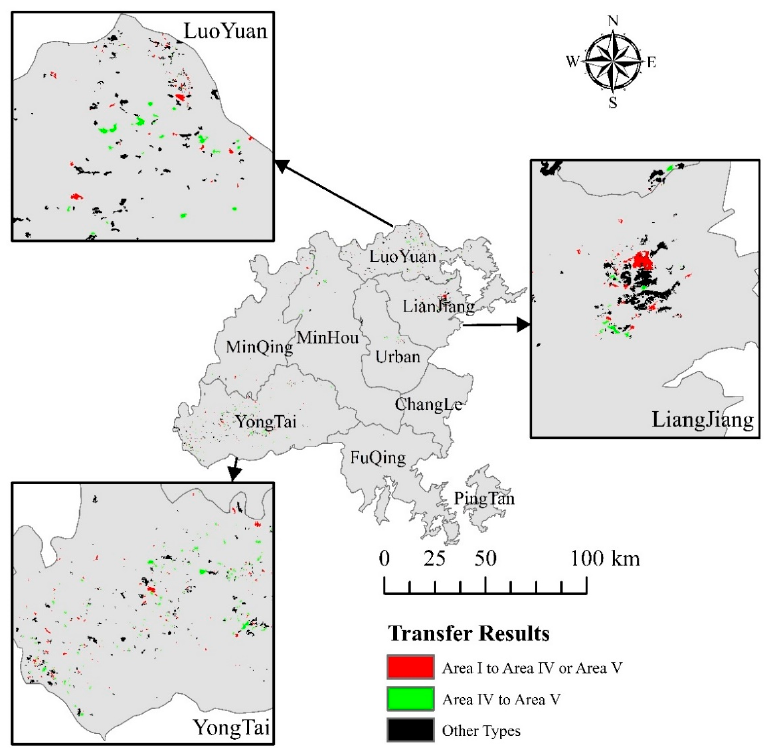
Figure 11. Example of tea garden cluster transfer